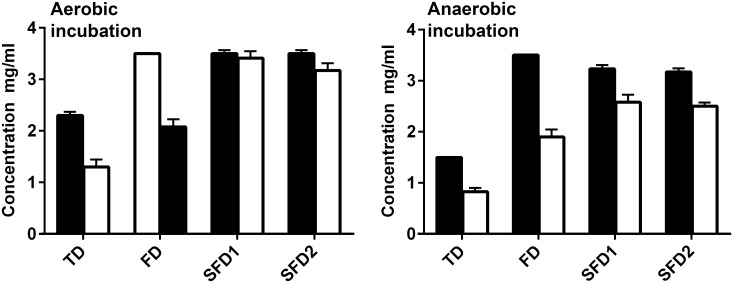
Minimum inhibitory concentrations (black bars) and minimum neutralizing concentrations (white bars) of test dentifrices (TD, FD, SFD1 and SFD2) in Tryptone Soya Broth under aerobic and anaerobic conditions.Error bars represent standard errors for three biological replicates, each with three technical repeats. Asterisks indicate statistically significant differences (p< 0.05) between MIC and MBC determined using a paired Student’s t-test.